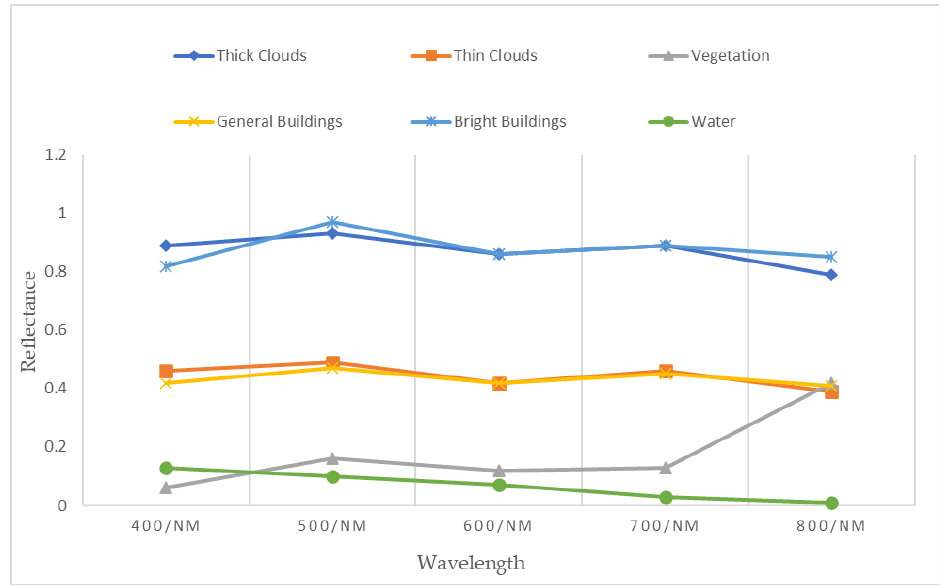
Figure 1. Spectral-contextual information of different typical objects in reflectance bands.